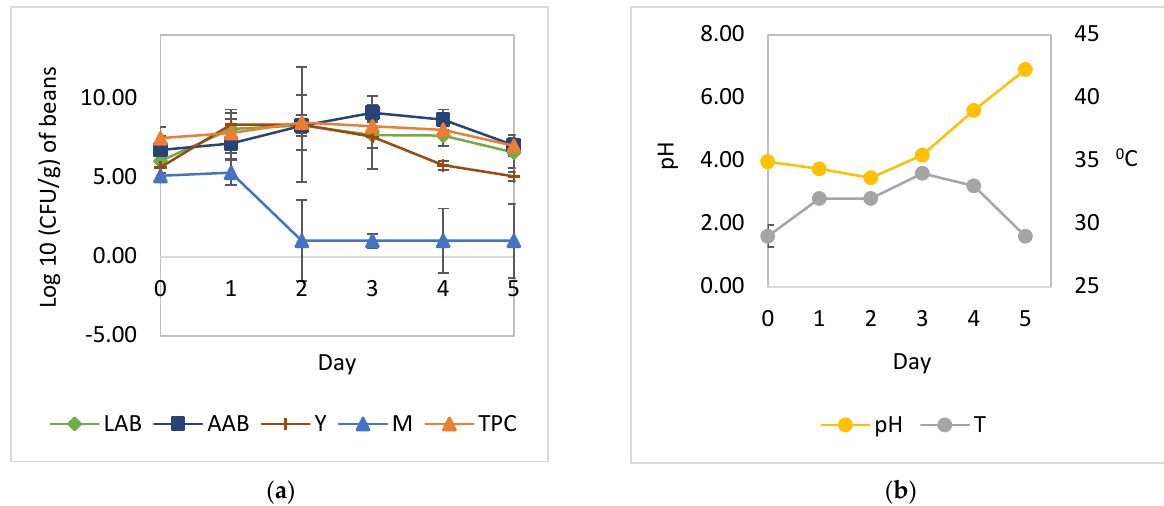
Figure 3. Microbial growth patterns and changes in pH and temperature during the natural fermentation of cocoa beans with the addition of A. niger YAC-9: ( a ) growth of yeast, LAB, AAB, and mold; ( b ) temperature and pH. LAB, total lactic acid bacteria; AAB, total acetic acid bacteria; Y, total yeast; M, total mold; TPC, total plate count; pH, pH pulp; T, temperature.